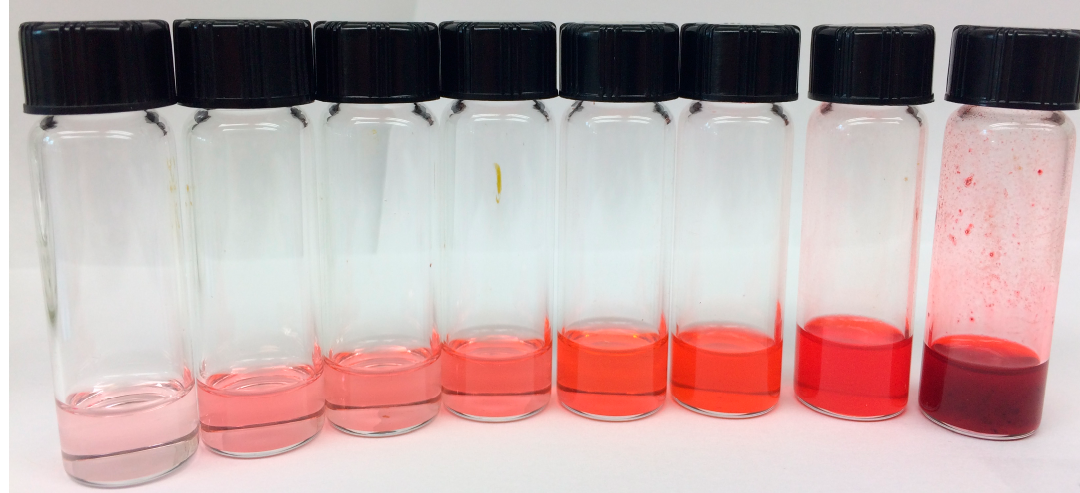
Figure 3. Varying Concentrations of the crystal ‘Dramada’ from Scytalidium cuboideum in DCM . Solution concentrations range from 0.024 mM to 19 mM of the pigment ( left to right ).